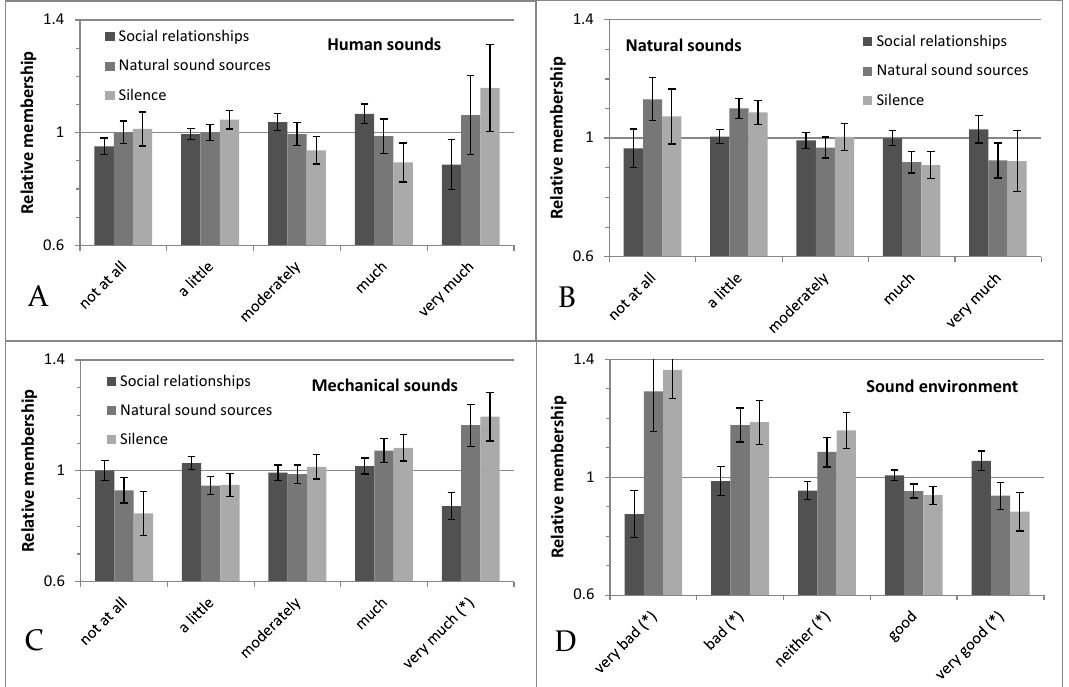
Figure 2. Relative membership to tranquility viewpoint groups shown in relation to hearing sound sources: ( A ) human, ( B ) natural and ( C ) mechanical. In ( D ): relative membership in relation to evaluation of the quality of the sonic environment is presented. Whiskers indicate one standard error of the dataset. A star indicates statistically significant difference confirmed by the analysis of variance between tranquility groups within one answer